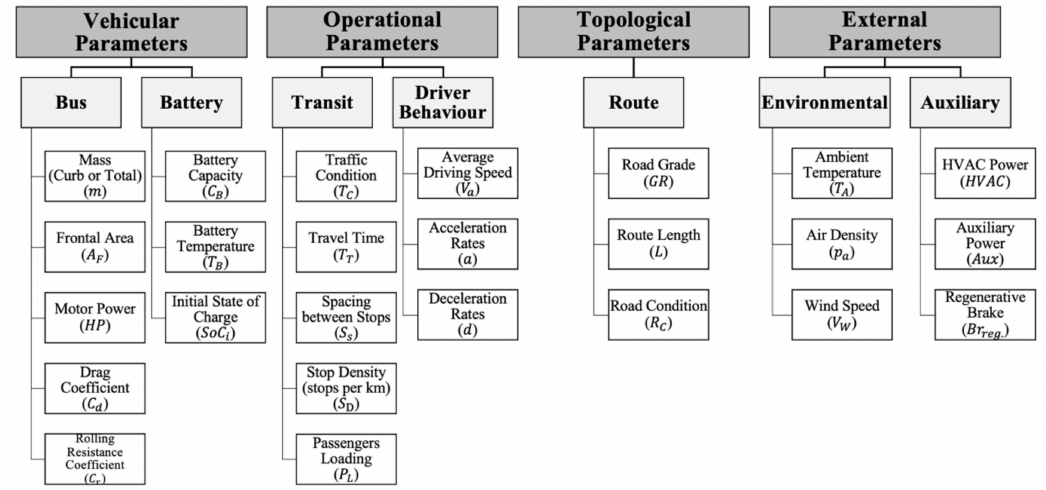
Figure 1. Parameters impacting the energy consumption of battery-electric